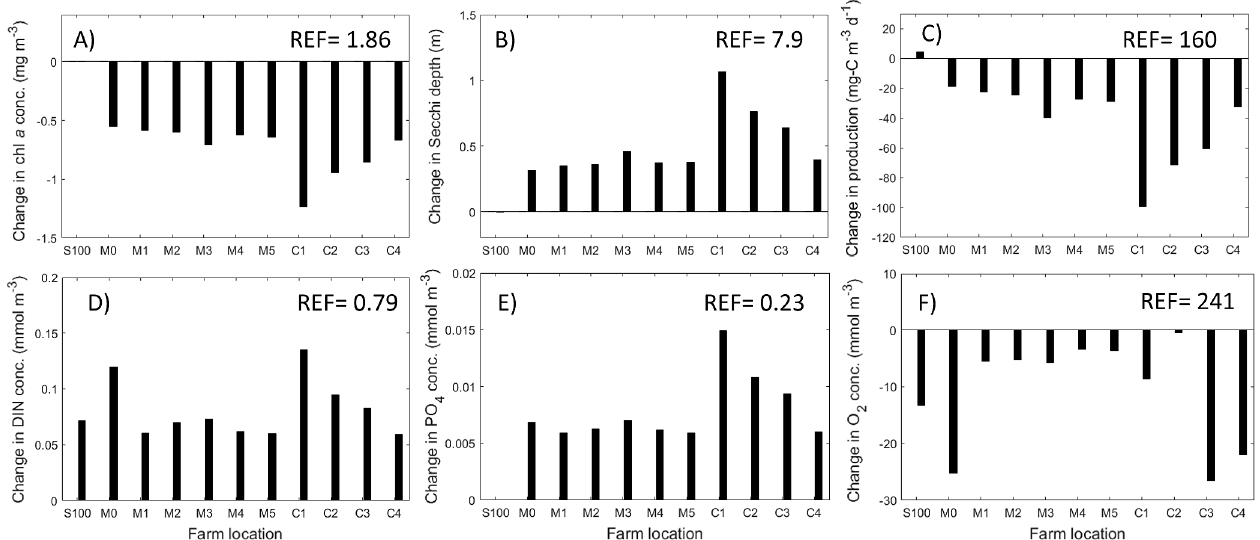
Fig. 7. Pelagic impact within the mussel farm area. Changes in (A) chl a concentration, (B) Secchi depth, (C) mesozooplankton production, (D) surface dissolved inorganic nitrogen (DIN) concentrations, (E) surface PO 4 concentrations and (F) bottom O 2 con- centrations in the different scenarios relative to the reference scenario (REF) from July to November. The mean values for REF at the fish farm location are shown in the upper right